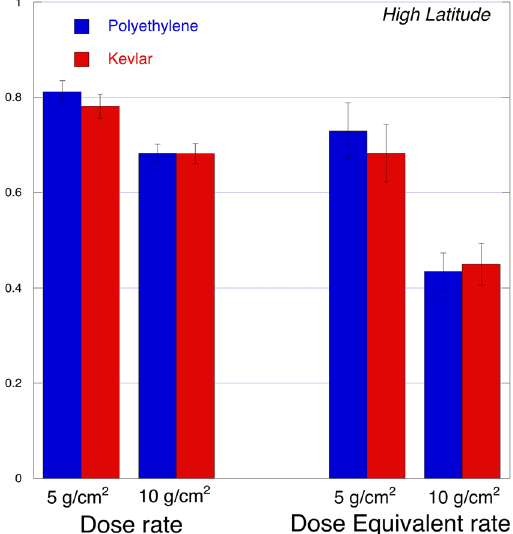
Figure 4. Dose rate and Dose equivalent rate ratios. Integrated Dose and Dose equivalent ratios (shielded measurements divided by not shielded measurements) for both Polyethylene (in blue) and Kevlar (in red); Ratio equal to one means that the shield doesn’t produce any reduction. Integration is performed in Linear Energy Transfer (LET) in water from 1.6 keV/ µ m to 207 keV/ µ